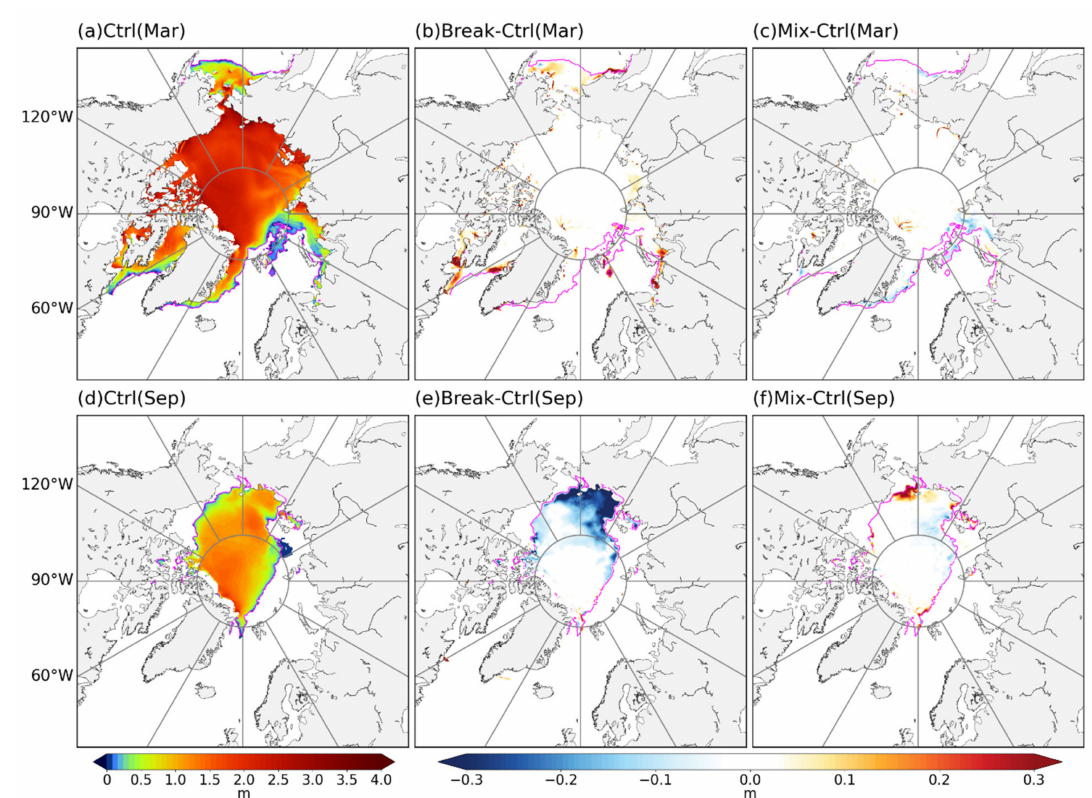
Figure 4. Sea ice thickness from the control run ( a ) in March, the differences between Break and Ctrl ( b ), and the differences between Mix and Ctrl ( c ). ( d – f ) Same as ( a – c ), but for September. The magenta line in ( a – c ) and ( d – f ) indicate the ice edge (sea ice concentration of 15%) for March and September in the Ctrl experiment, respectively.